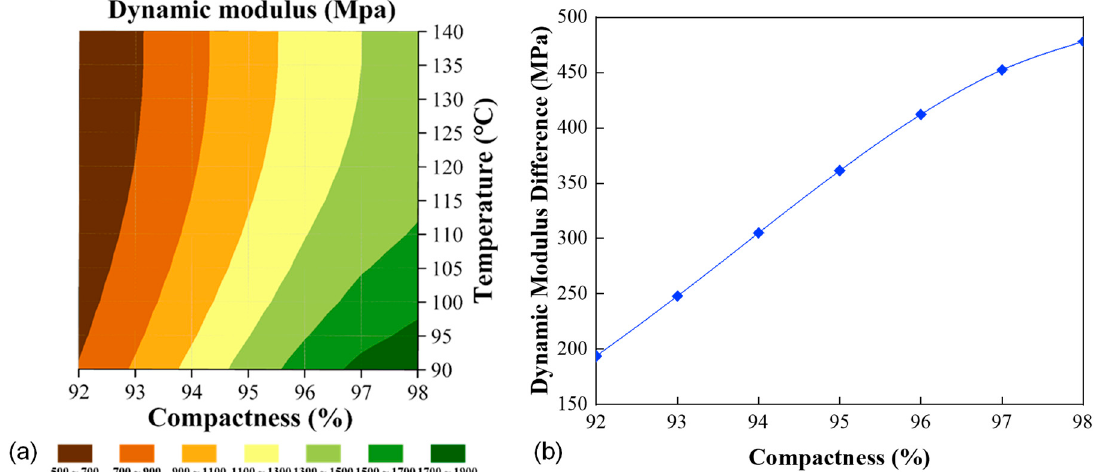
Figure 11. The confined moduli predicted at the field compaction conditions: ( a ) distribution of the moduli, and ( b ) difference between the moduli at the temperatures of 90 °C and 140 °C.